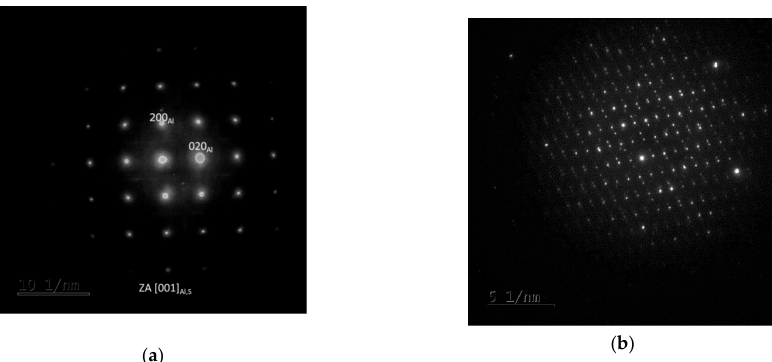
Materials 2020 , 13 , x FOR PEER REVIEW Figure 10. EDS maps of specimen W-0RS-160. Figure 10. EDS maps of specimen W-0RS-160.